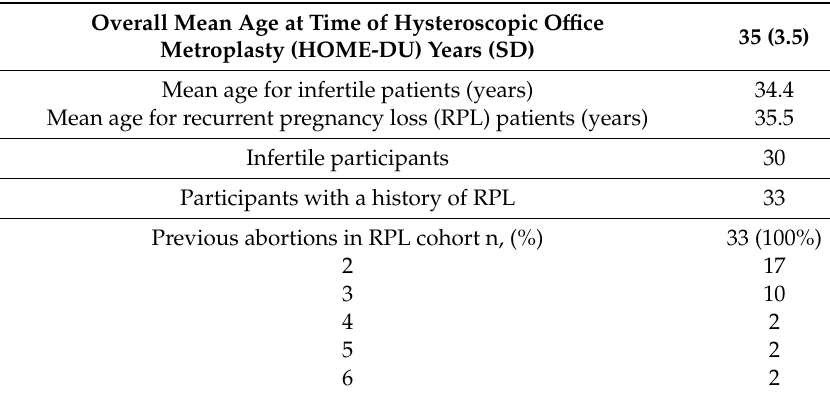
Table 1. Participant disposition ( n =